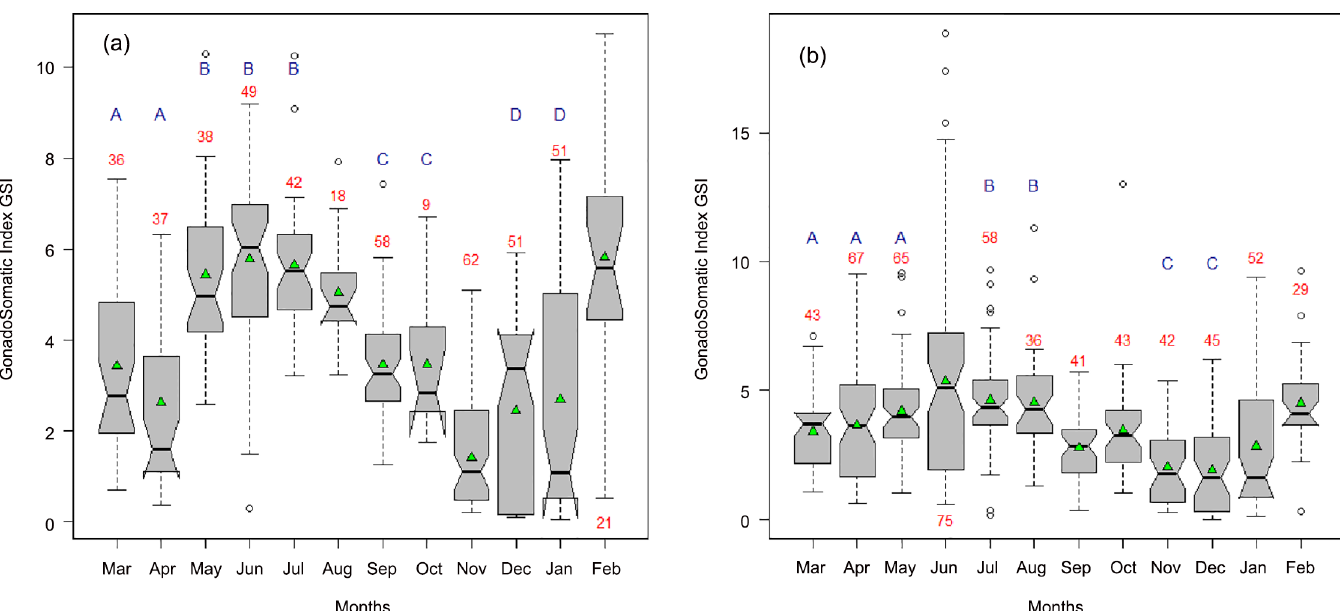
Fig 10. (a) male and (b) female gonadosomatic index (GSI) of Sardinella maderensis between March 2012 and February 2013. The means are represented by green triangles inside the notched box plots. Red figures under the error bars are the sample sizes. Months with the same blue letters (A-E) are not significantly different according to the Kruskal-Wallis test.